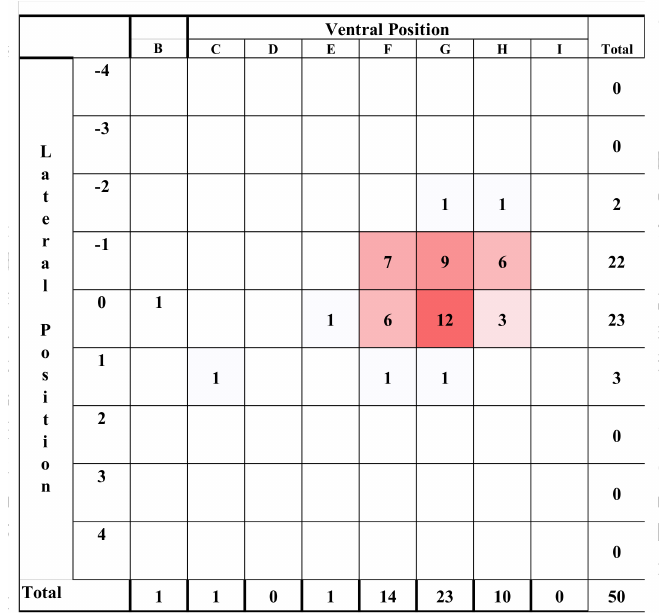
Figure 16. Heat map of the distribution of shooting positions for the 50 lambs. Lateral target area, with 0 representing the midline based on the suture of the paired frontal bones with positive values to the LHS and negative values to the RHS of the head (see Figure 8). Ventral targeting areas using surface topography with F representing a shot on the frontal-parietal suture, G on the parietal bone, H on the parietal-occipital suture etc., with C rostral to the head (Figure